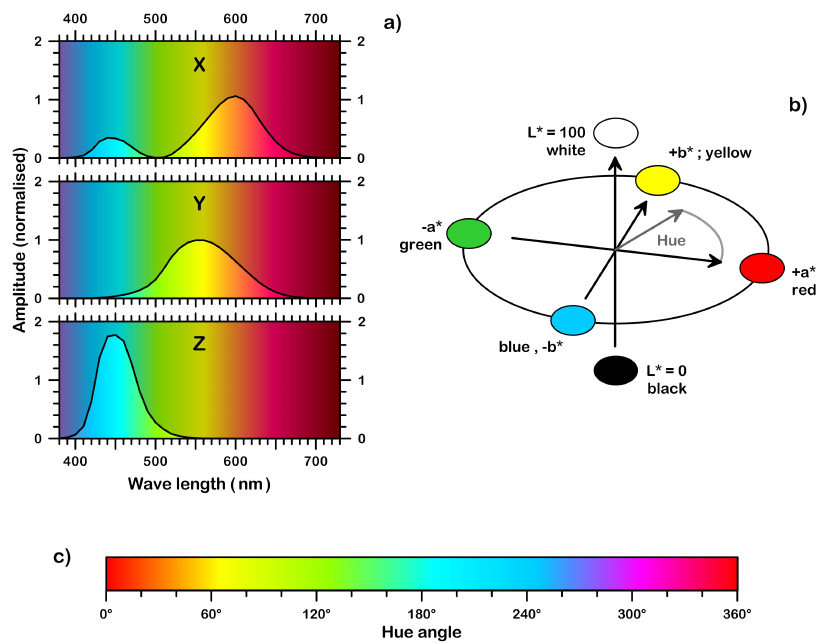
Fig. 2. Some basics in colour processing: (a) 2 ◦ -observer weighting functions for spectrum integration in order to obtain the tristimulus values ( X,Y,Z ), (b) L ∗ a ∗ b ∗ colour space and definition of the hue angle as also shown in (c) , together with corresponding colours. Note that colours are more schematic rather than